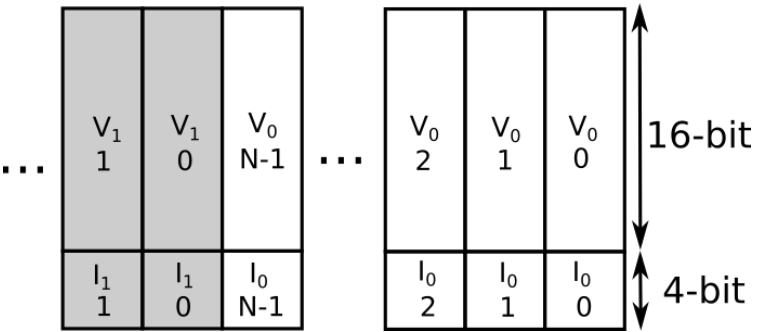
Figure 5. Layout of CFG-MEM